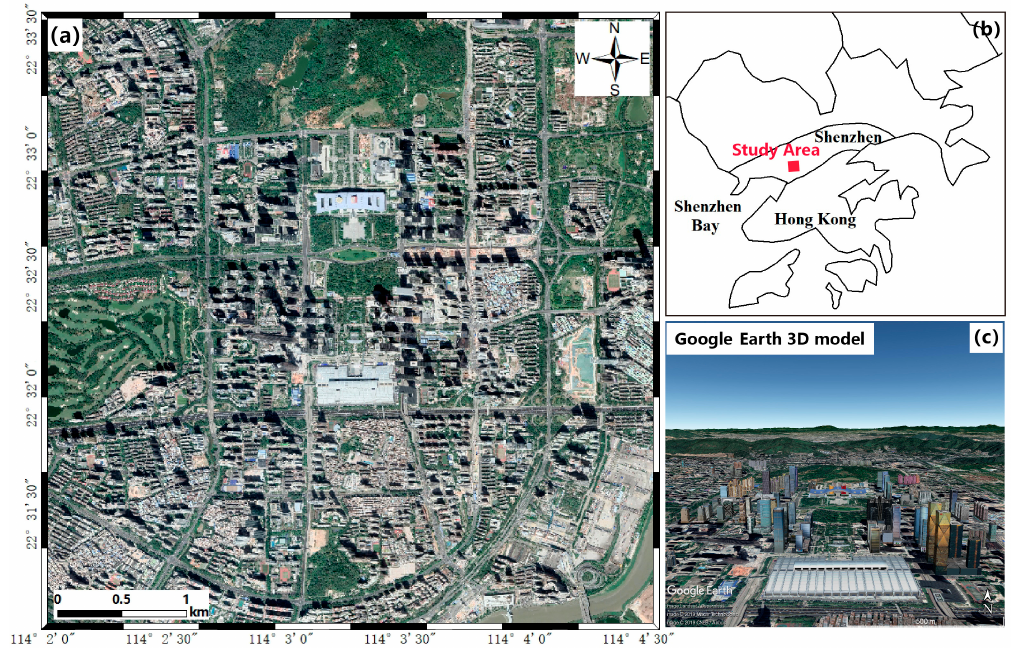
Figure 1. ( a ) Optical image of the Futian District in Shenzhen, ( b ) geographic location of study area, and ( c ) Google Earth 3D model of the Futian District in Shenzhen.